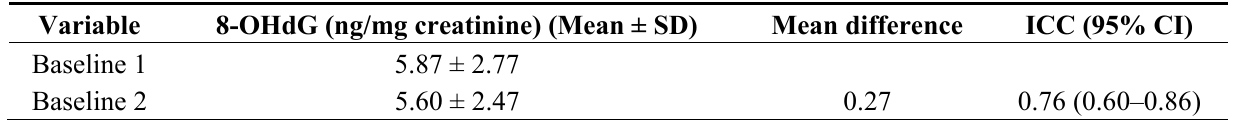
Table 2. The test-retest reliability of 8-OHdG from the two baseline measures in patients with stroke ( N = 45). Abbreviations: 8-OHdG, 8-hydroxy-2'-deoxyguanosine; CI, confidence interval; ICC, intraclass correlation coefficient; SD, standard deviation.